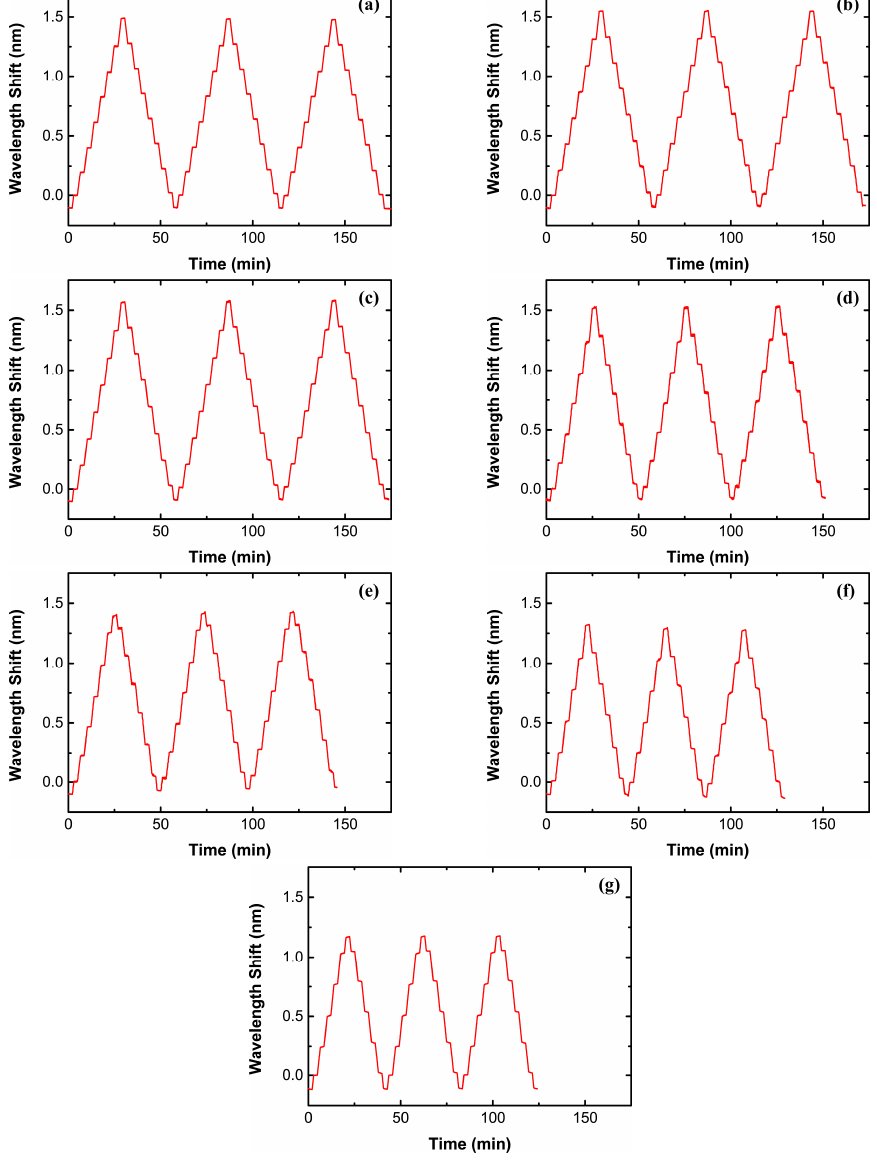
Figure 10. Temporal evolution of the wavelength shift during the mechanical loading cycles for the metal-packaged strain sensor based on the RFBG in H 2 -loaded PS1250/1500 fiber at constant temperatures of 26.5 °C ( a ); 100 °C ( b ); 200 °C ( c ); 300 °C ( d ); 400 °C ( e ); 500 °C ( f ) and 540 °C ( g ).